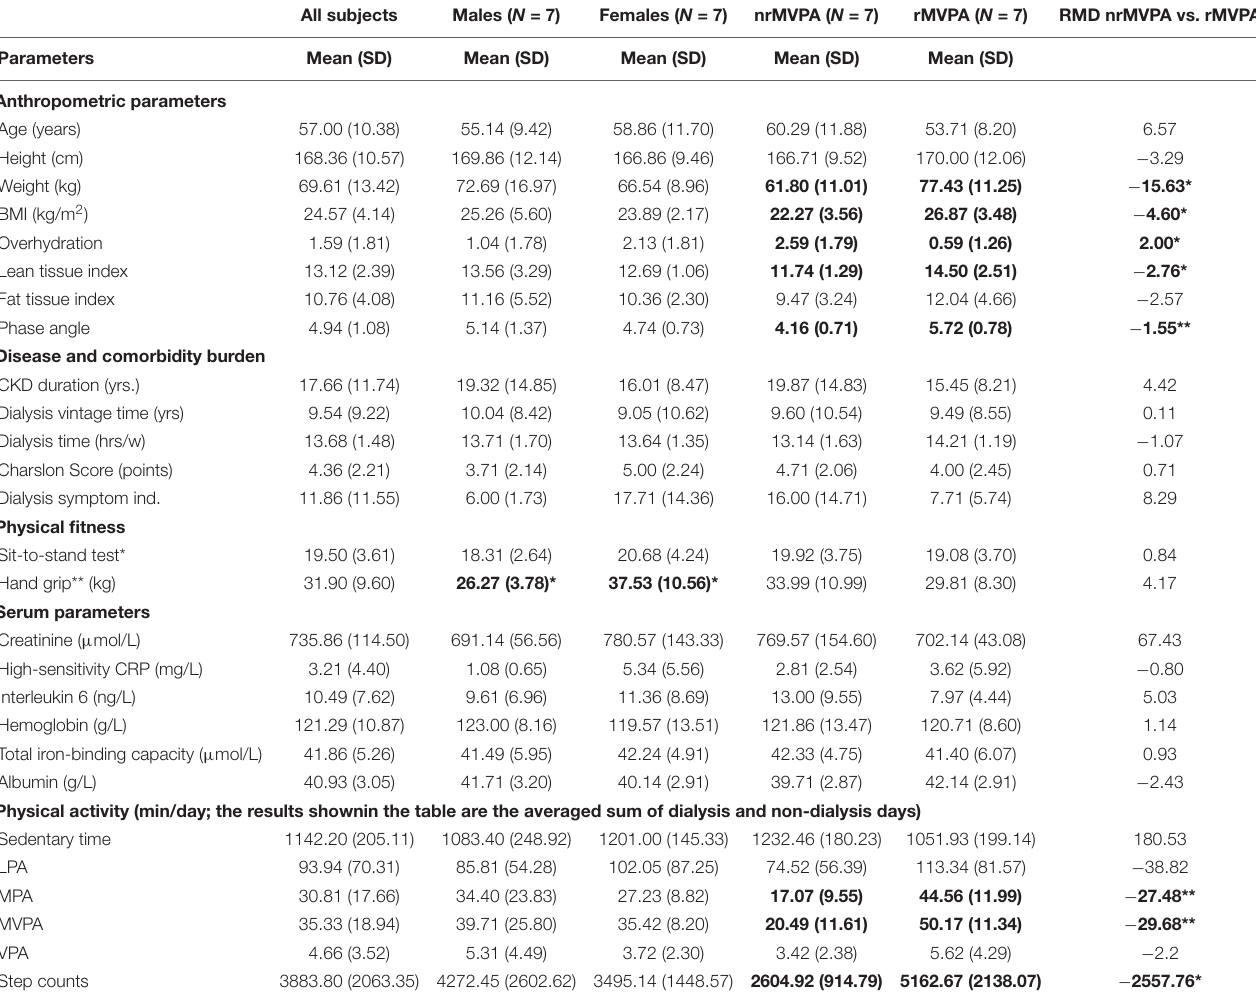
TABLE 1 | Basic demographic characteristics of hemodialysis patients and comparisons between males and females and patients reaching and not reaching physical activity recommendations. All